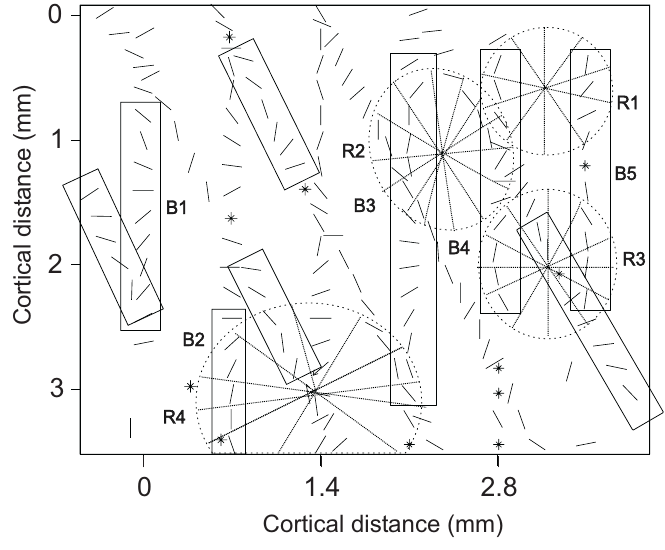
Fig. 4 – Patterns of axis-of-motion columns revealed by a manual plot of recep- tive field properties in two oblique crossing planes. Small bar shows the axis-of- movementselectivityforeachrecordingsite. Theellipsesshowradialarrangements orpinwheelsandtherectanglesshowbandsoflineararrangements. (Seealsolegend for Figure